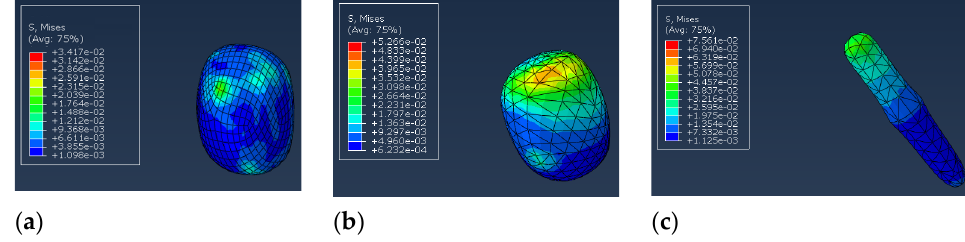
Figure 9. Stress cloud diagram of kiwifruit picking and packing. ( a ) peel; ( b ) flesh; ( c ) placenta.